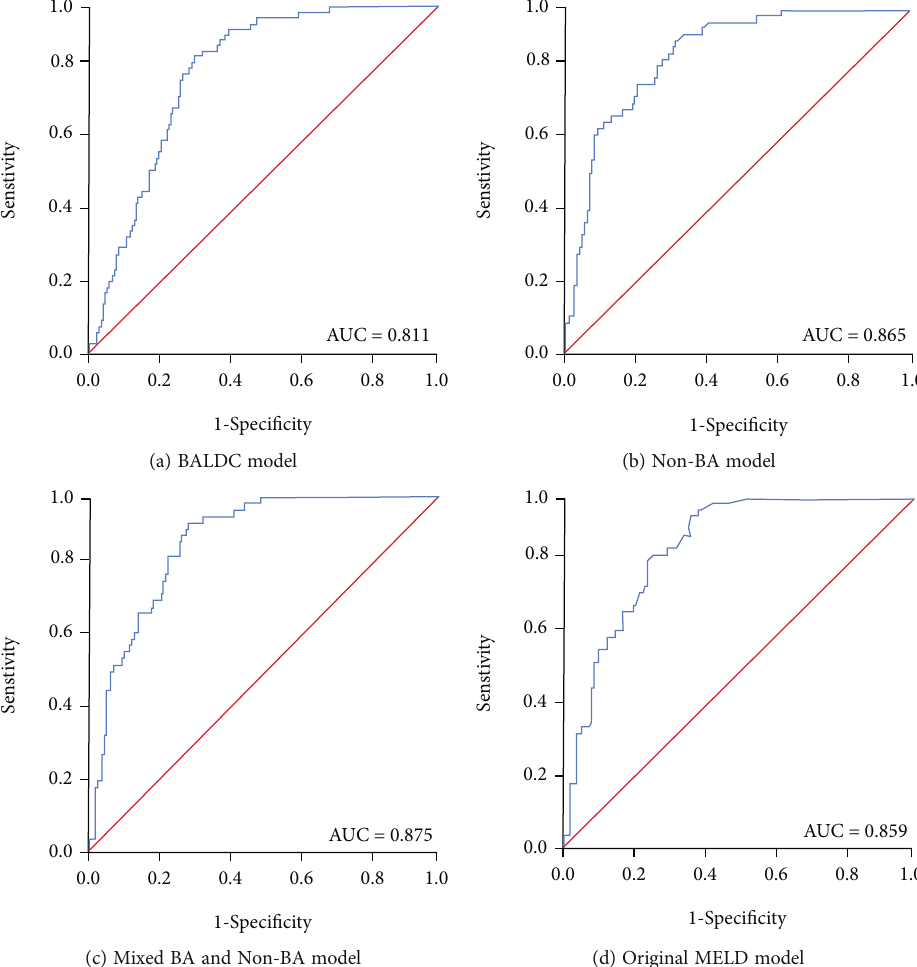
Figure 2: Receiver operating characteristic (ROC) curves of the BALDC, non-BA, mixed BA and non-BA, and original MELD models for ascites prediction. The area under the ROC curves (AUC) for (a) BALDC model, (b) non-BA model, (c) mixed BA and non-BA model, and (d) original MELD model for di ff erentiating patients with ascites from patients without